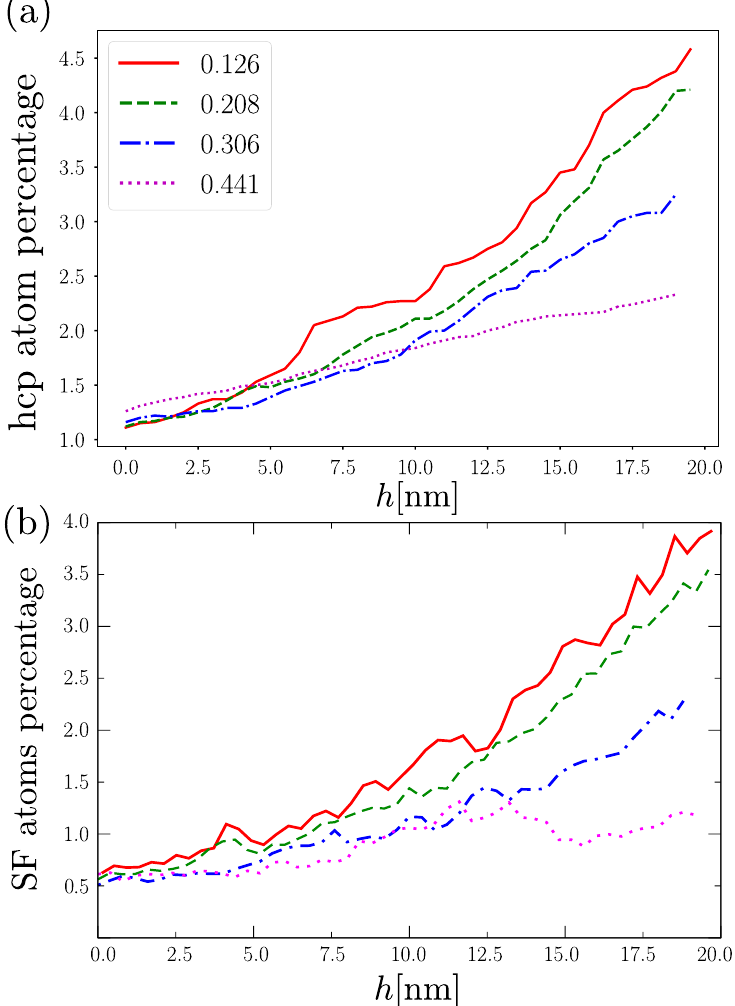
Figure 6. ( a ) % of hcp atoms as function of the indentation depth for φ = 0.126,0.208,0.306,0.441. ( b ) % of atoms belonging to SF as function of the indentation